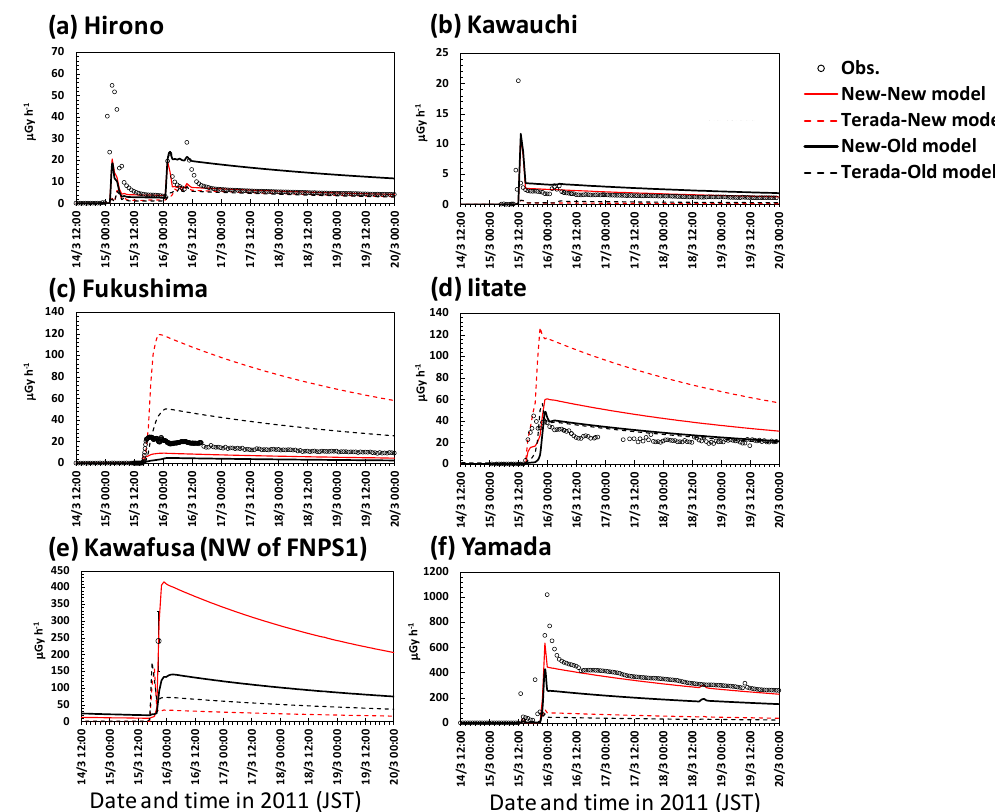
Figure 12. Temporal changes in the air dose rates in Fukushima Prefecture from 15 to 16 March 2011 in the four simulations using original and modified WSPEEDI-II (referred as “Old model” and “New model”, respectively) and Terada at al. (2012) and the new source terms (referred as “Terada” and “New”, respectively). Locations of the monitoring points are shown in Fig. 2. The error bar with observational data in (e) represents the range of values measured by Geiger-Müller survey meters and ionization chambers at three locations from 20:40 to 20:50 on 15 March (MEXT,